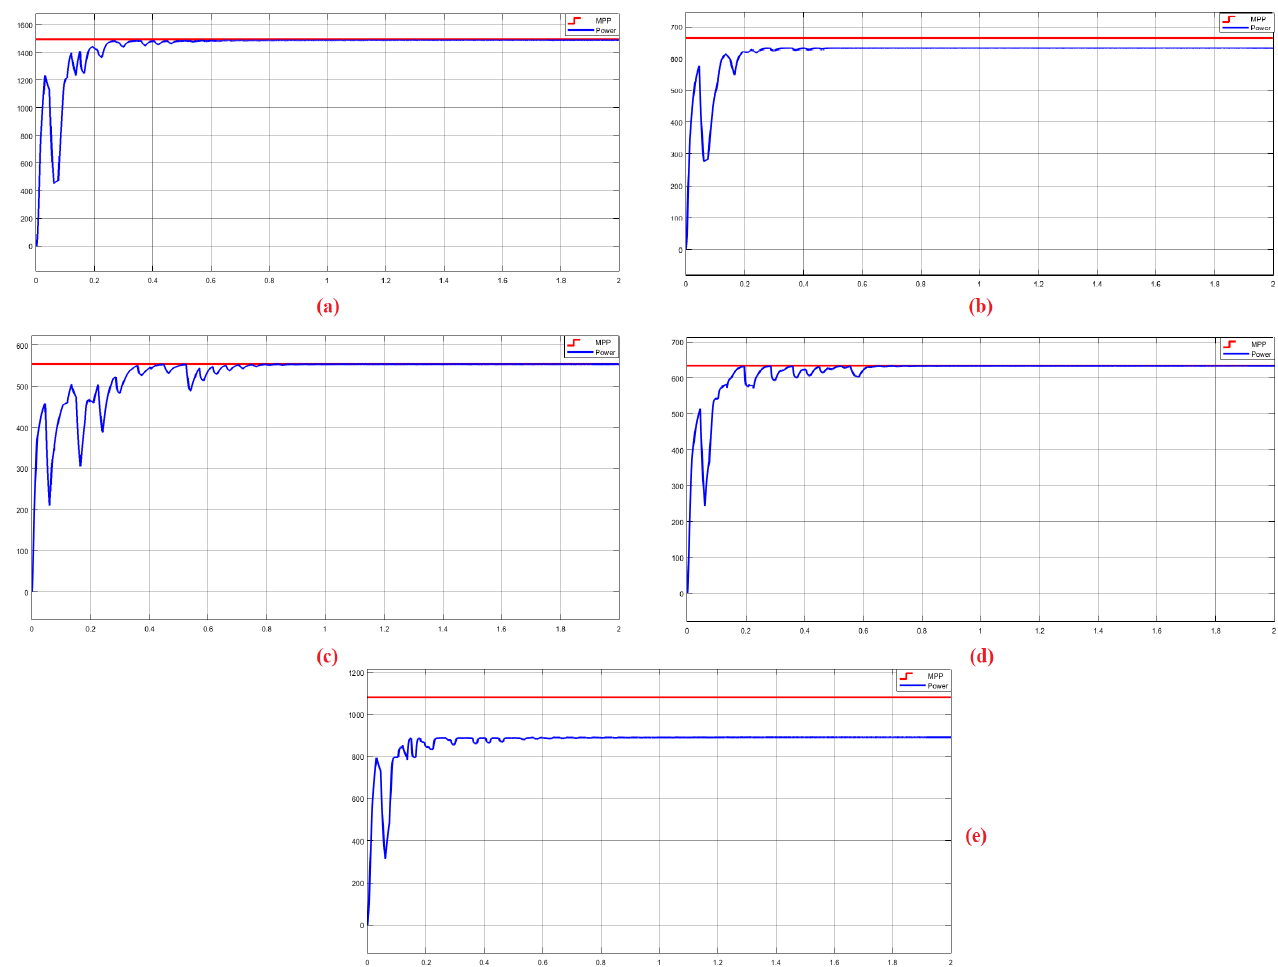
Figure 13. The power–time graph of CSA under different shading conditions. ( a ) For the UIC graph; ( b ) For the second CPSC graph; ( c ) For the third CPSC graph; ( d ) For the fourth CPSC graph; ( e ) For the fifth CPSC graph.